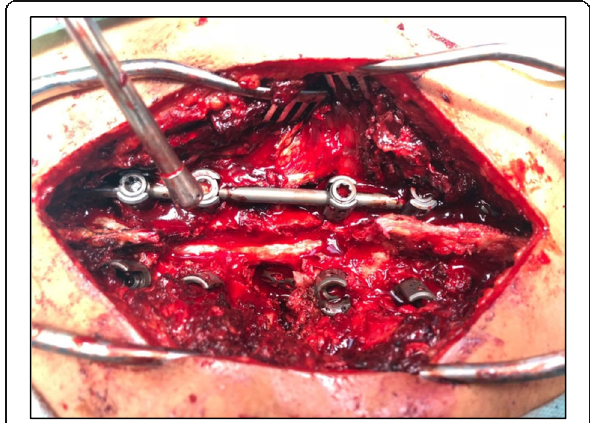
Fig. 1 Placement of the titanium pyramesh after corpectomy